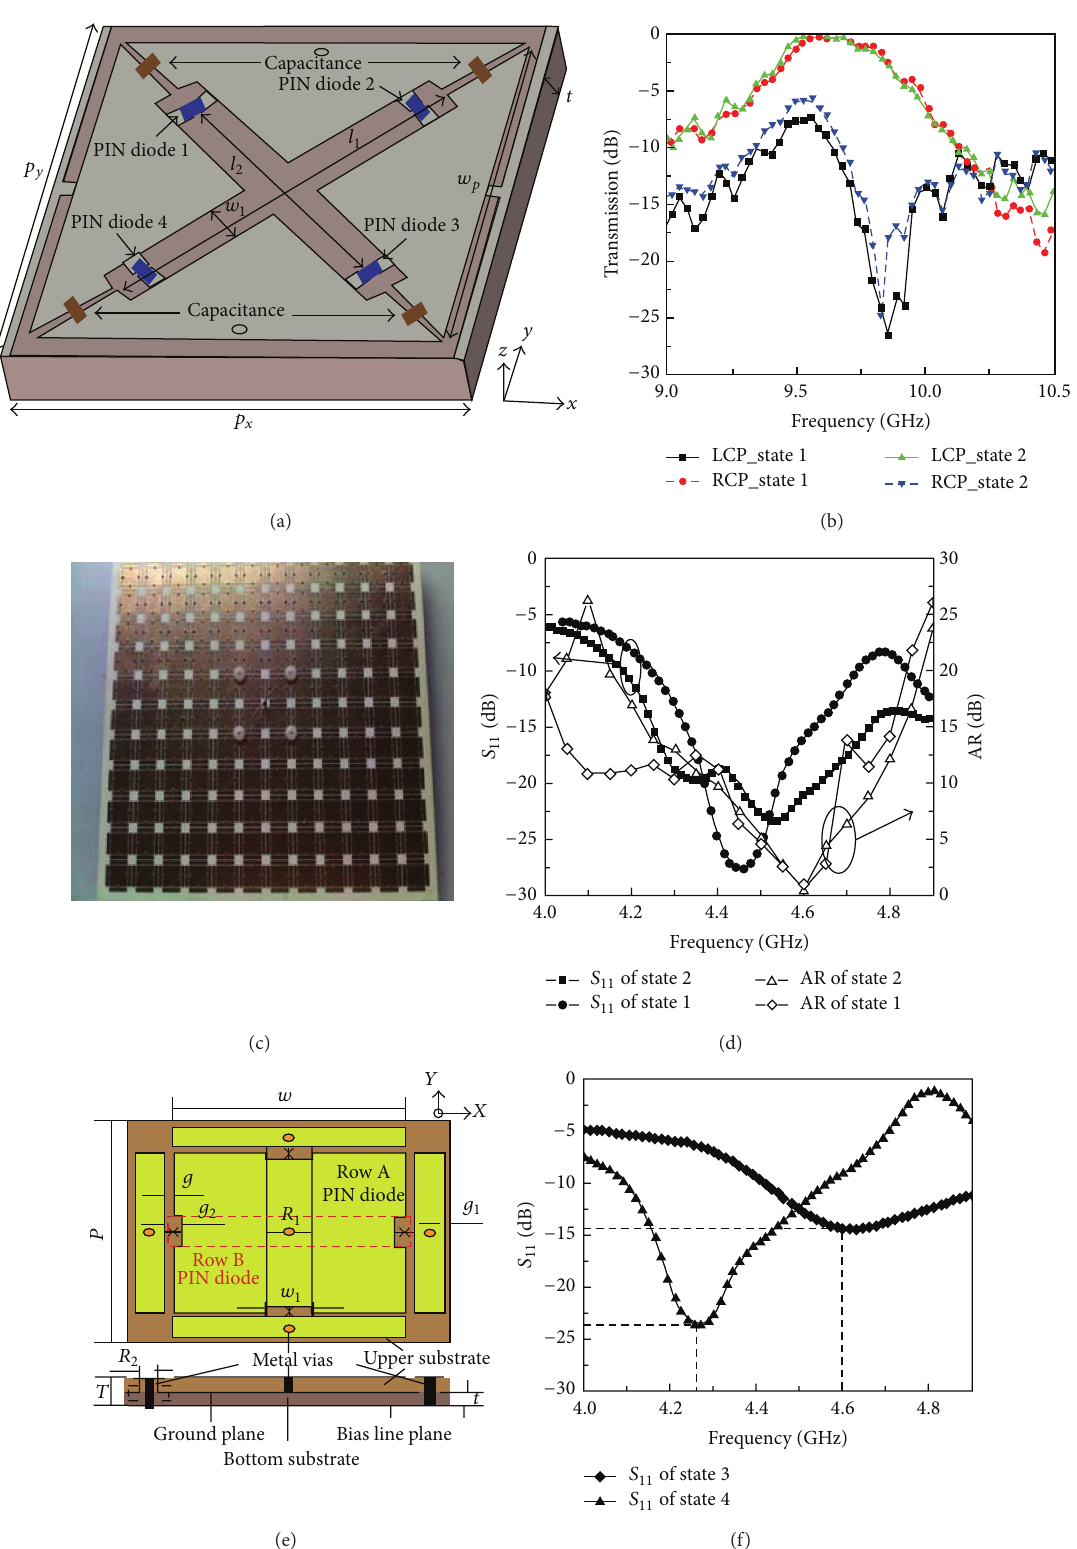
Figure 42: (a) Schematic of the metamolecule of the active metasurface for polarization manipulation, and the transmission spectra are shown in (b). (c) Photography of the fabricated dipole antenna using tunable metasurface with its unit cell in (e), and the measured 𝑆 11 and AR of the designed dipole antenna for different working states are shown in (d) and (f). Figures are reproduced from